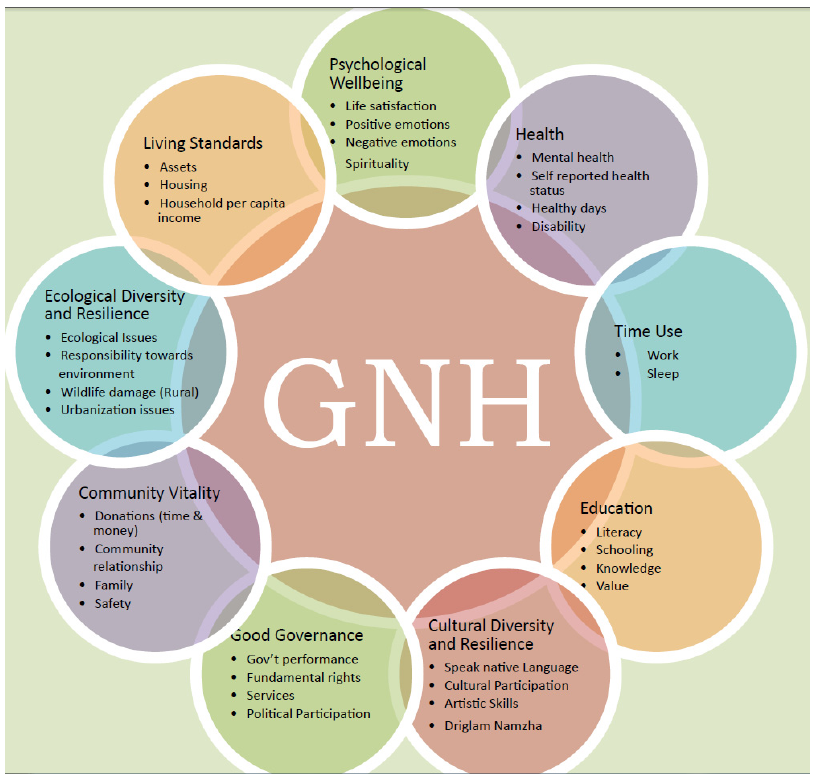
Figure 1. GNH index: nine domains. Source: Reprinted with permission from (Ura et al. 2012, p. 13).